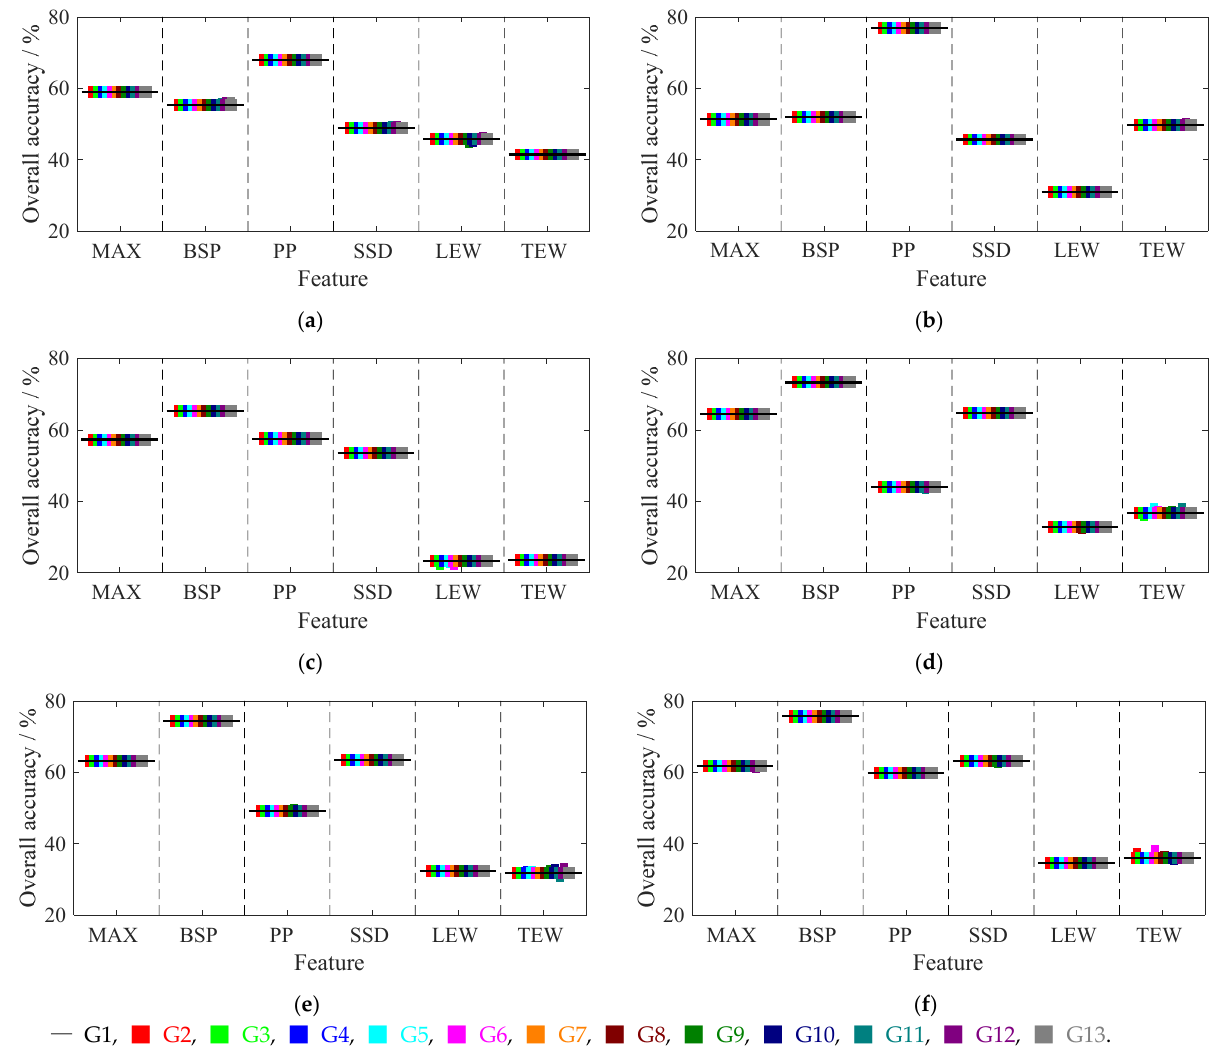
Figure 8. Overall accuracies of 13 groups of training data expressed by G1–G13 at six incidence angles: ( a ) 0°; ( b ) 2°; ( c ) 4°; ( d ) 6°; ( e ) 8°; ( f ) 10°.